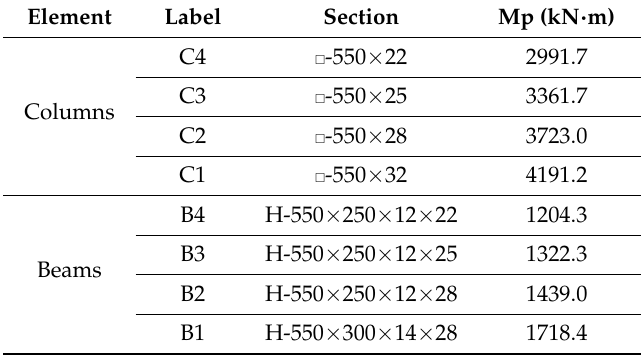
Table 1. Sections and plastic moments of the columns and beams of a twelve-story steel moment resisting